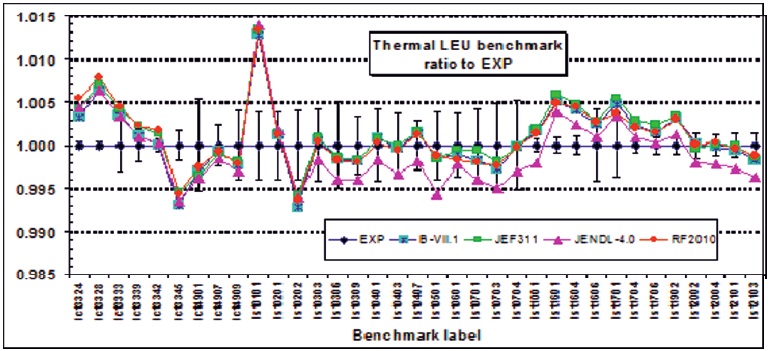
Fig. 4: Thermal LEU